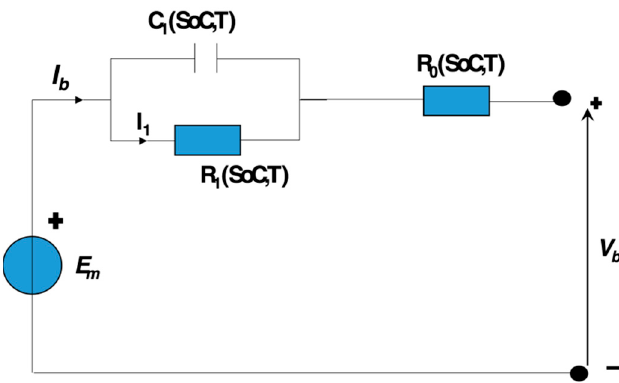
Figure 2. Block diagram of the cell model.